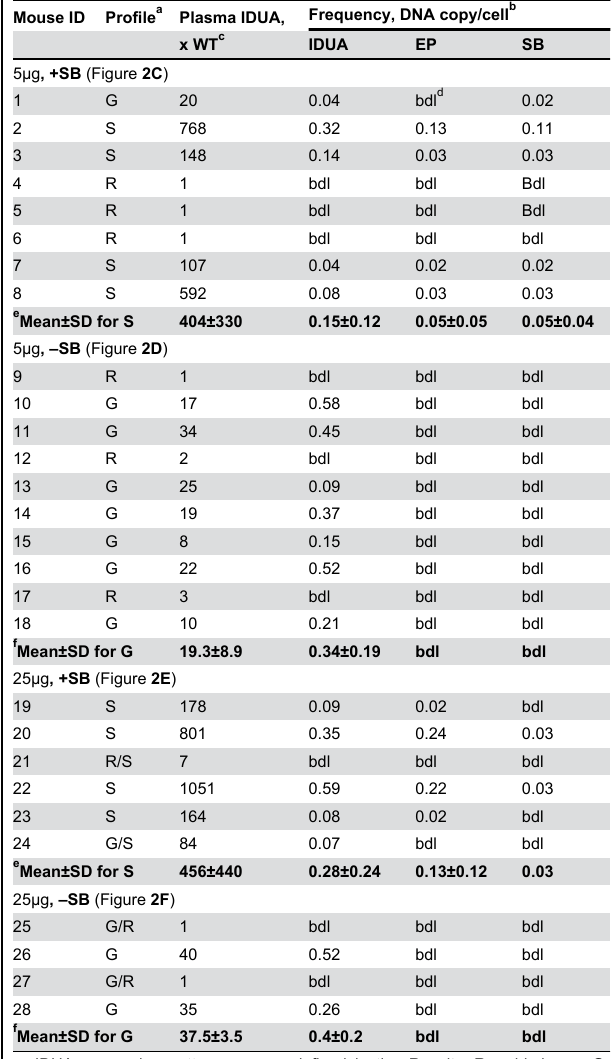
Table 1. IDUA expression profiles and activity in plasma vis-à-vis transposition and transgene/plasmid maintenance in liver of immunosuppressed C57BL/6 mice one year post-